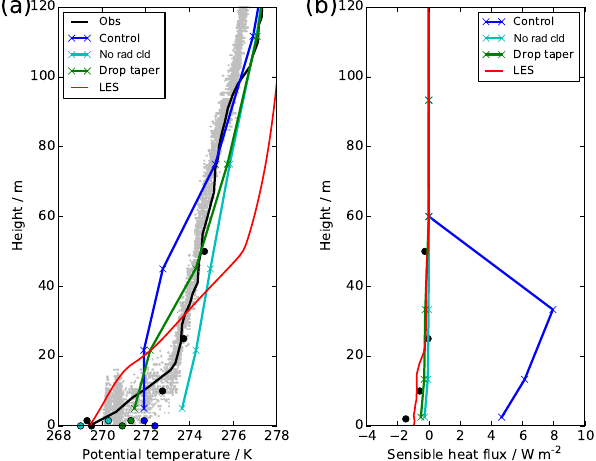
Figure 3. Profiles at 22:30UTC showing observations (mast: black circles, radiosonde: black line, tethered balloon: grey dots), LES (red) and UKV experiments: control (blue), radiatively inactive cloud (cyan) and modified droplet number (green), showing (a) po- tential temperature and (b) sensible heat flux. Model profiles show model-level data (crosses) and diagnosed screen and surface-level temperature (filled